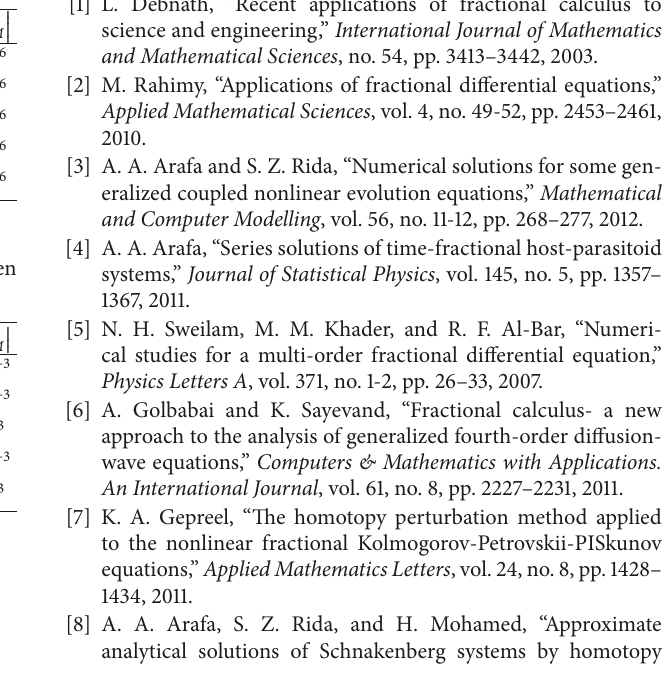
Table 1: The absolute errors |𝑢 𝑒𝑥𝑎𝑐𝑡 −𝑢 3 | for Gardner equation when 𝑡 = .2, 𝜀 = 1, 𝛼 󳨀→ 1.